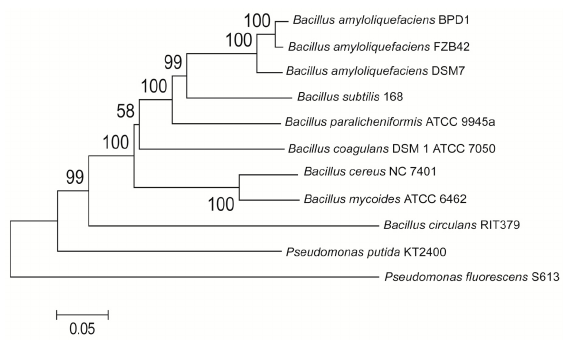
Figure 1. Neighbor-joining phylogenetic tree analysis of Bacillus spp. based on gyrA nucleotide sequences (2246 bp) using Pseudomonas spp. as an outgroup. The evolutionary distances were calculated by the p-distance method based on 1000 bootstrap replication. The phylogenetic tree was computed using the MEGA6.0 program. (Molecular Evolutionary Genetics Analysis, a free software obtained from